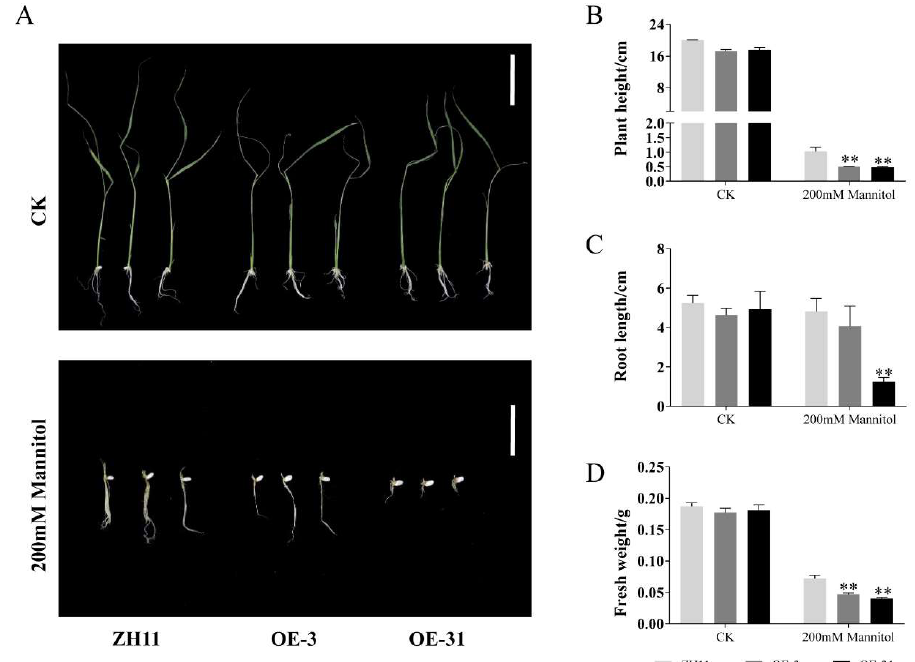
Figure 5. Drought stress tolerance of AcWRKY31 overexpression rice plants. ( A ) Performance of ZH11 and AcWRKY31 overexpression rice plants with or without drought treatment for 10 days; scale bar = 5 cm. The plant height ( B ), root length ( C ) and fresh weight ( D ) of all lines in ( A ). Bars show standard deviations of at least 10 seedlings. Asterisks indicate significant differences between the ZH11 and the AcWRKY31 overexpression lines evaluated with Student’s t test (** p < 0.01). To explore whether AcWRKY31 is also involved in the process of salt stress response, the seedings of ZH11, OE-3 and OE-31 were seeded in 1/2 MS medium with or without 150 mM NaCl. The results showed that the plant height, root length and fresh weight of AcWRKY31 overexpression rice seedlings OE-3 and OE-31 was significantly reduced com- pared with those in ZH11 after salt stress treatment, which indicated that overexpression of AcWRKY31 increases rice sensitivity to salt stress (Figure 6).